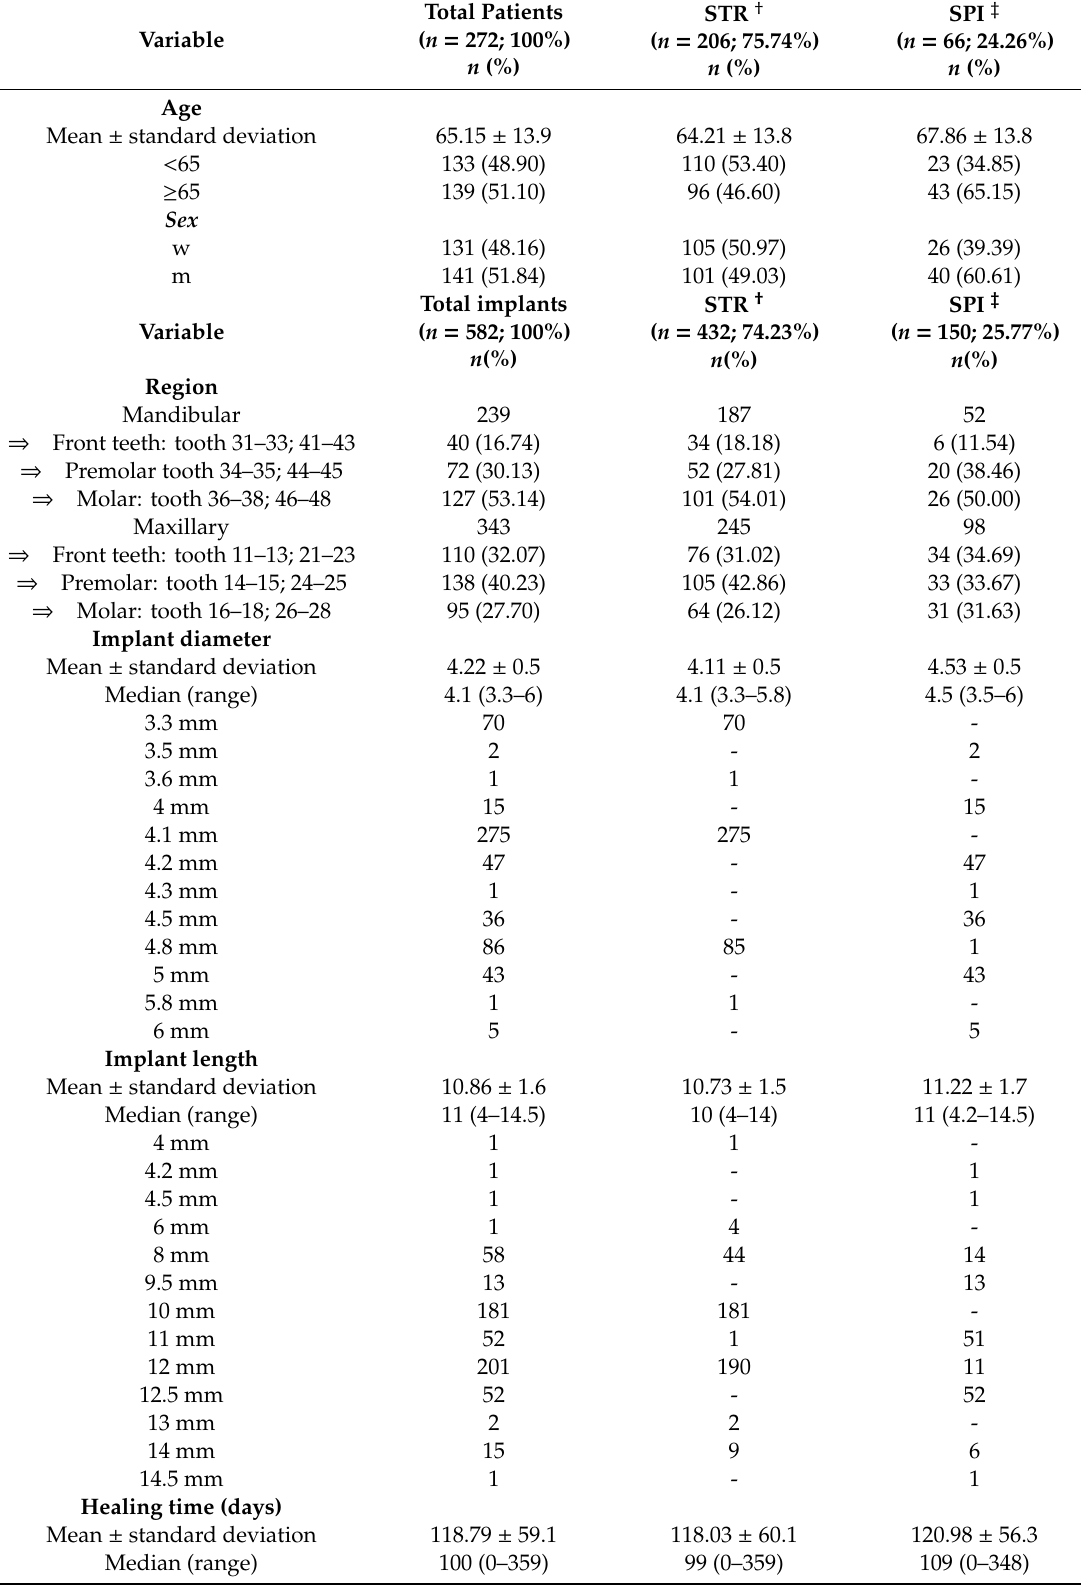
Table 1. Descriptive characteristics of patients and